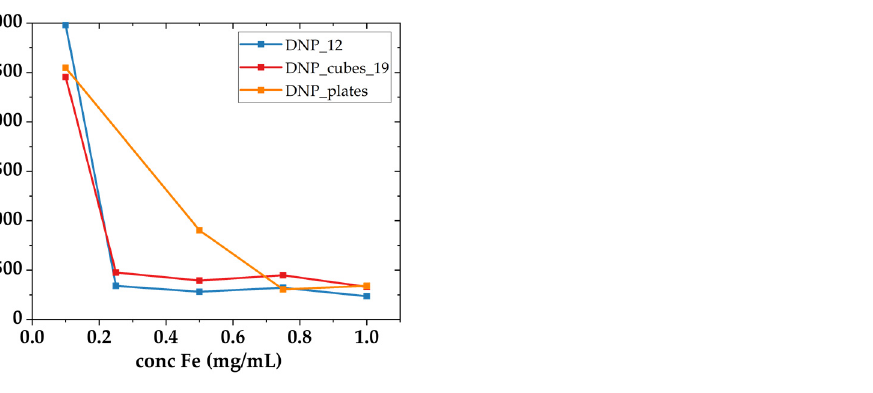
Figure 8. SAR values as a function of iron concentration in mg/mL for the batches DNP_12, DNP_cubes_19, and DNP_plates.